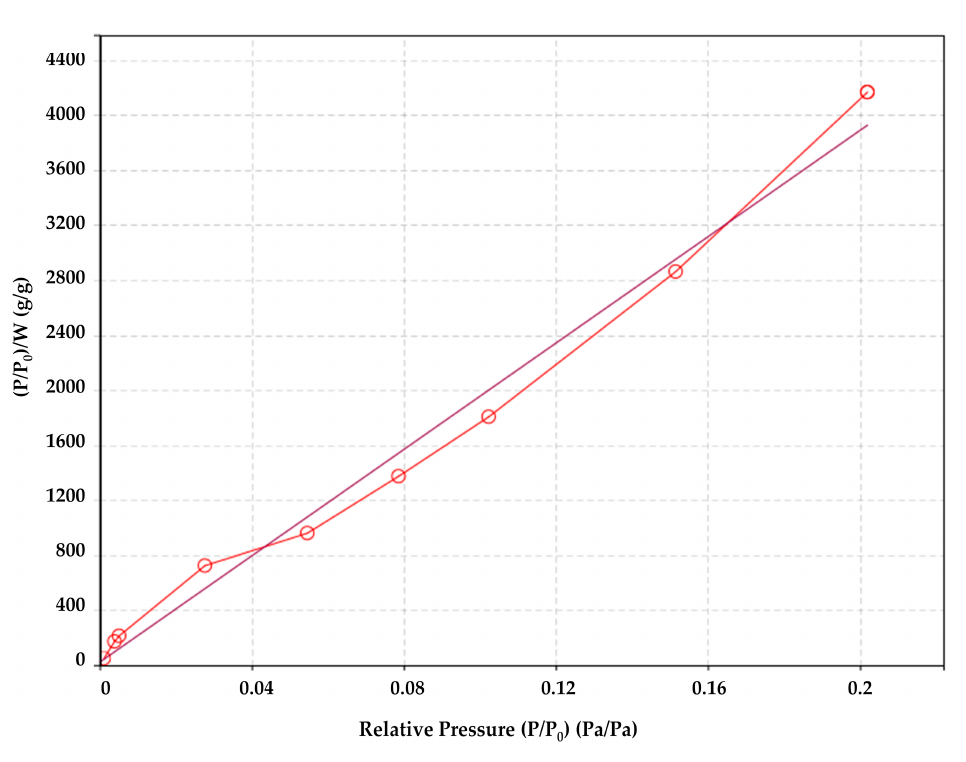
Figure 3. Brunauer–Emmett–Teller (BET) analysis of the specific surface area of the sized fibers.